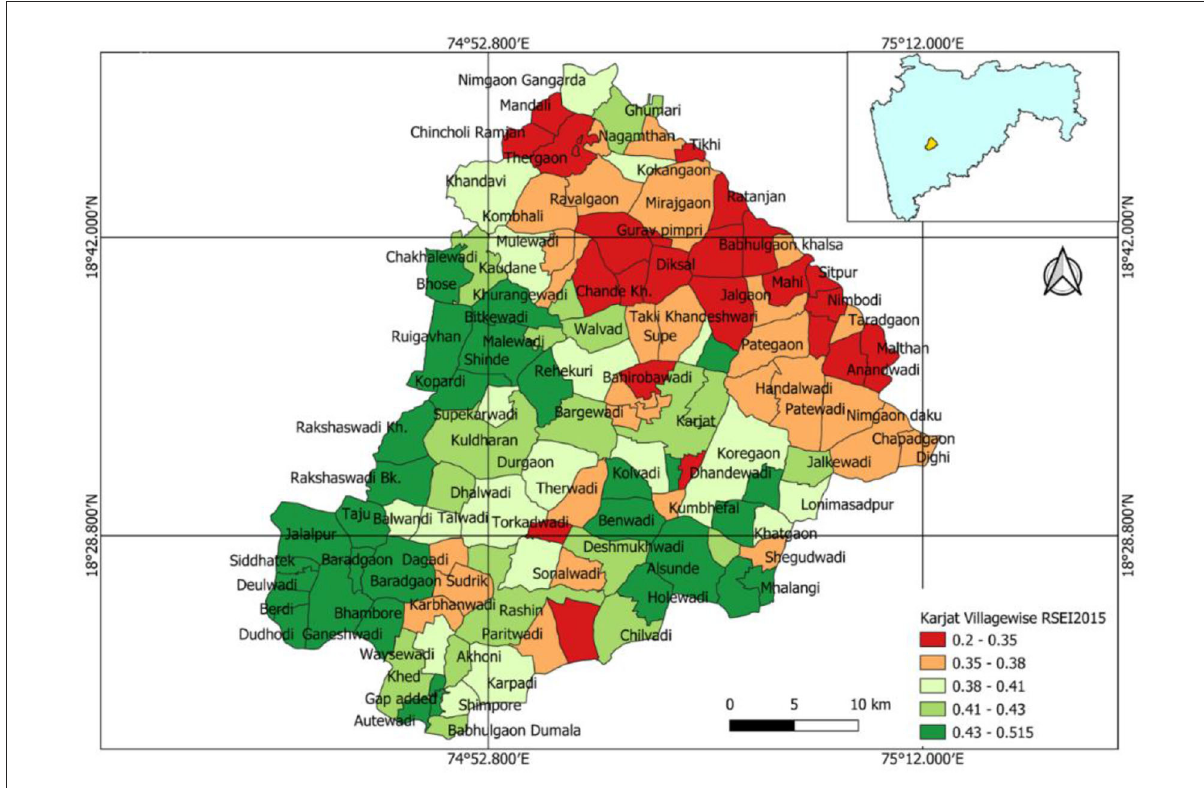
FIGURE7 Village-wise RSEI of Karjat taluka for the year